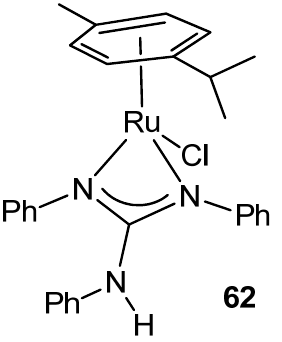
Figure 35. Iron dianionic guanidinato compounds.